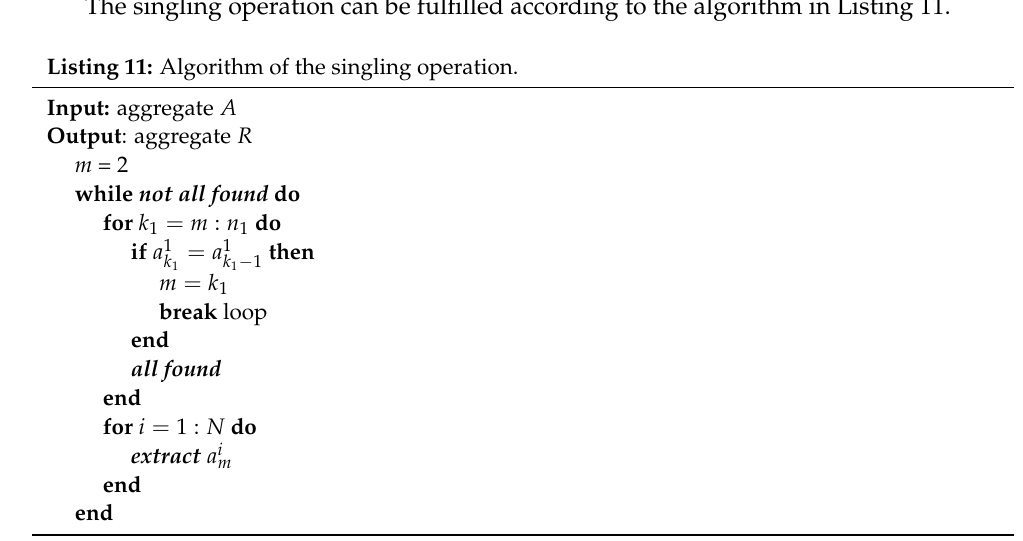
Figure 4. An example of two hiddenly compatible aggregates.